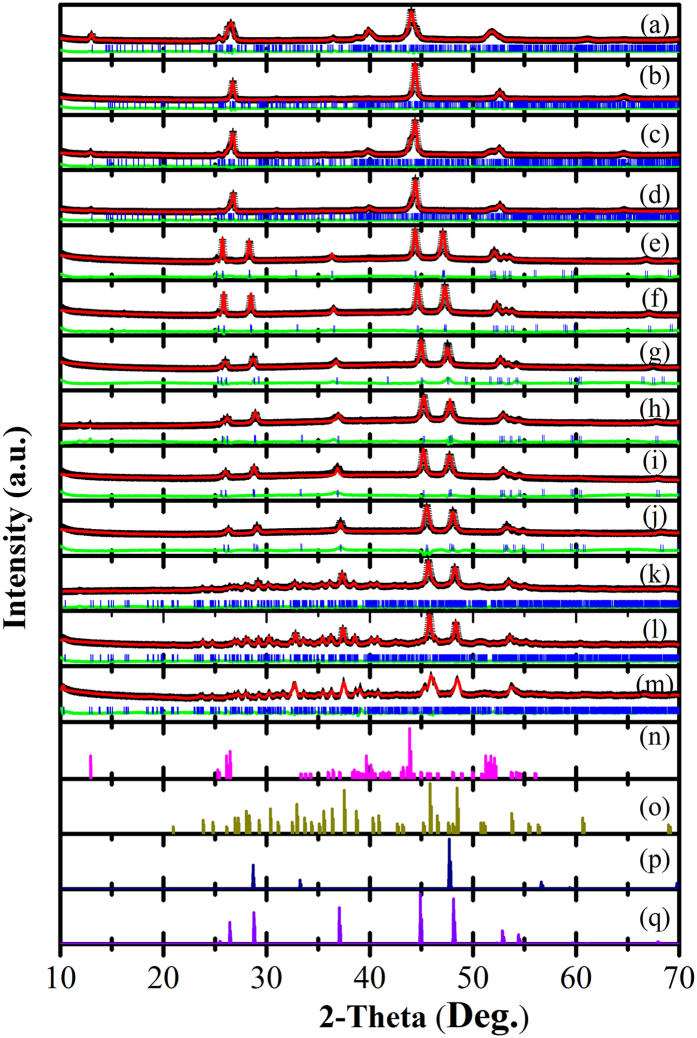
X-ray diffraction (XRD) patterns of the fabricated Cu1.98SxSe1−x (x = 0, 0.02, 0.08, 0.16, 0.2, 0.3, 0.4, 0.5, 0.6, 0.7, 0.8, 0.9, 1.0) samples: (a) Cu1.98Se, (b) Cu1.98S0.02Se0.98, (c) Cu1.98S0.08Se0.92, (d) Cu1.98S0.16Se0.84, (e) Cu1.98S0.2Se0.8, (f) Cu1.98S0.3Se0.7, (g) Cu1.98S0.4Se0.6, (h) Cu1.98S0.5Se0.5, (i) Cu1.98S0.6Se0.4, (j) Cu1.98S0.7Se0.3, (k) Cu1.98S0.8Se0.2, (l) Cu1.98S0.9Se0.1, (m) Cu1.98S, (n) standard XRD pattern for monoclinic structured Cu2Se, (o) standard XRD pattern for orthorhombic structured Cu2S, (p) standard XRD pattern for cubic structured Cu1.8Se, and (q) standard XRD pattern for hexagonal structured Cu2.001S. (+ data points, − calculation line, − difference line, | marker points).